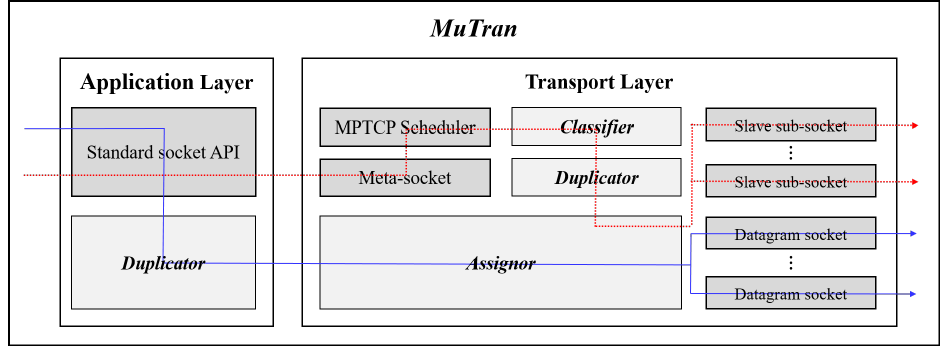
Figure 3. The structure and operation flow of MuTran .